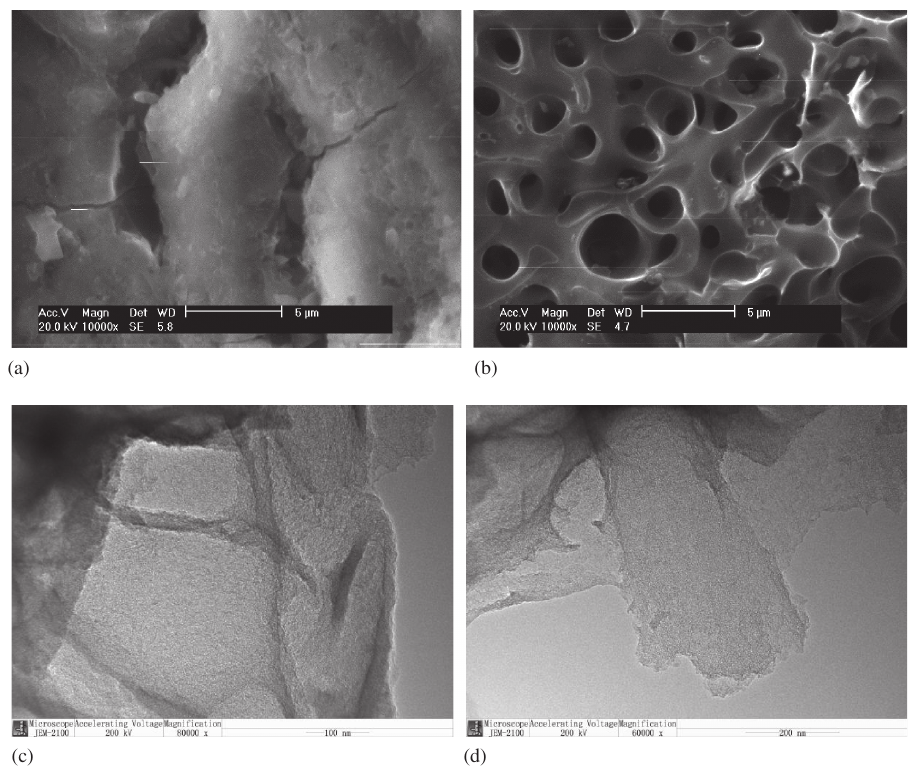
Figure 7: Scanning electron microscopy (SEM) images of char (a), HSAAC(b), TEM images of HSAAC